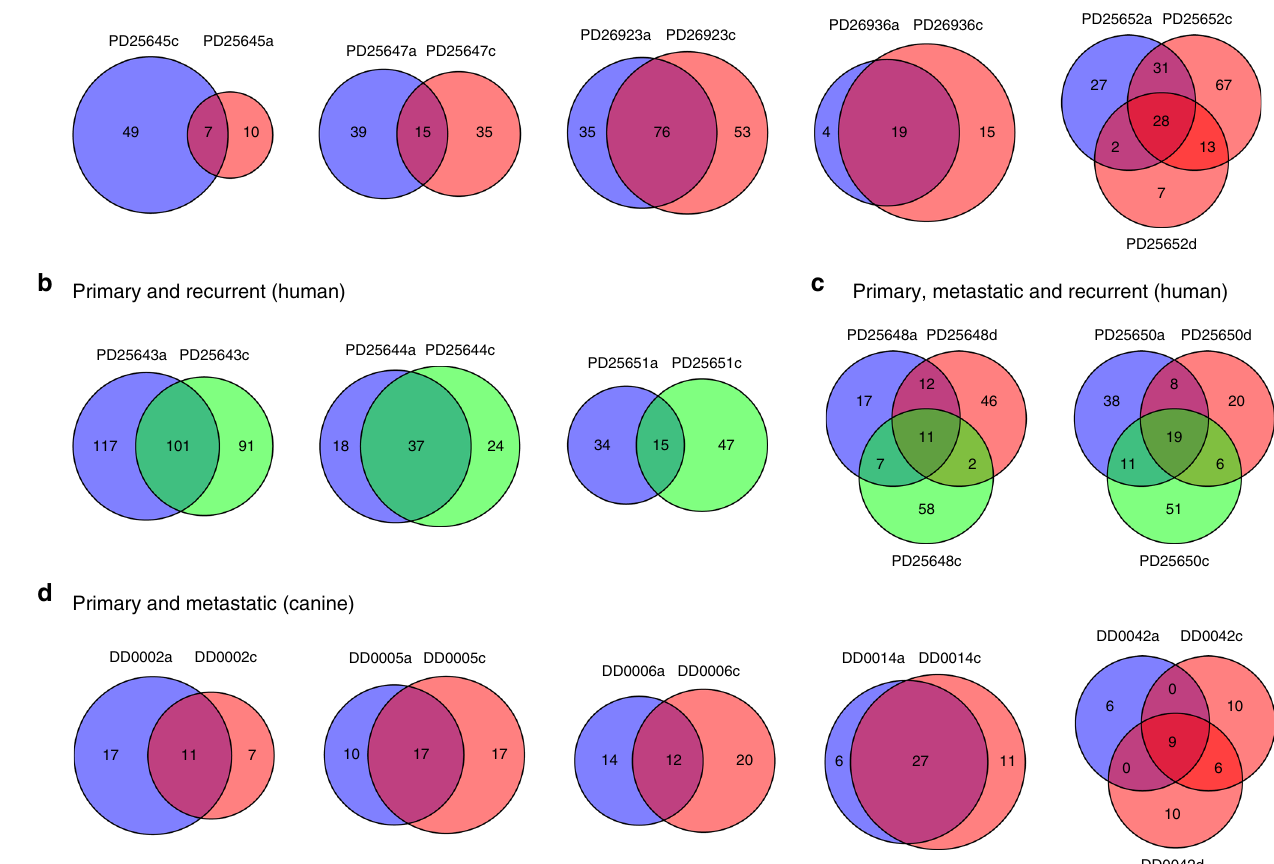
Fig. 6 Comparison of somatic mutations in recurrences and metastases to primary tumors. Shown are the number of shared and private mutations in each sample. Blue represents primary tumors, red represents metastatic tumors, and green represents recurrent tumors. Tumor details can be found